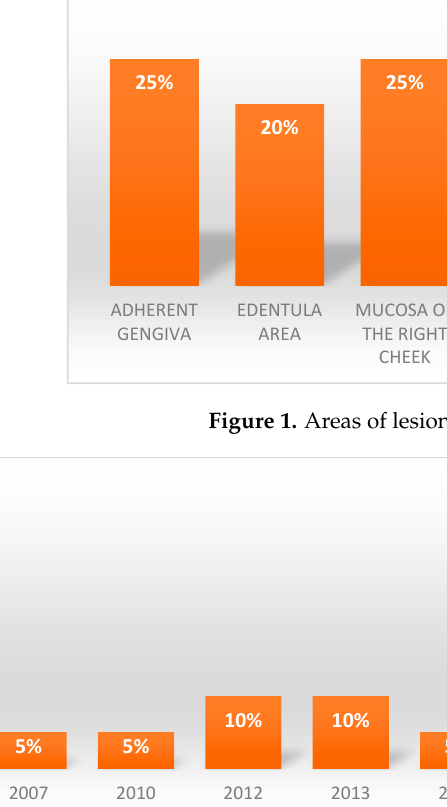
Figure 2. Year of onset of the lesions.